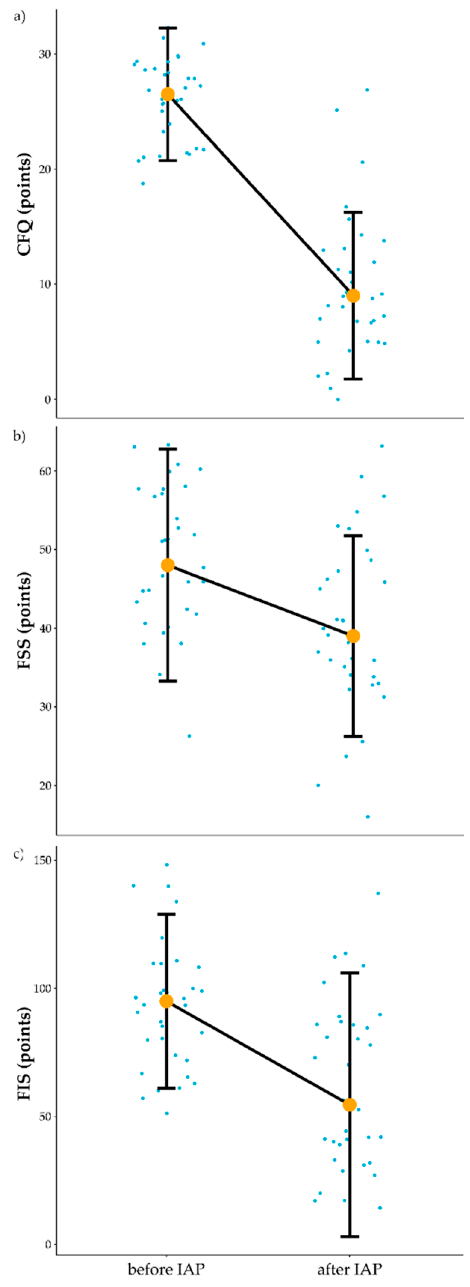
Figure 2. Influence of IAP on fatigue scales. ( a ) influence of IAP on CFS—Chronic Fatigue Scale. ( b ) influence of IAP on FSS—Fatigue Severity Scale. ( c ) influence of IAP on FIS—Fatigue Impact Scale. IAP—Individualised Activity Program, Orange dots connected by black line indicate median value, vertical black lines denote interquartile range. Blue dots before and after denote results of individual